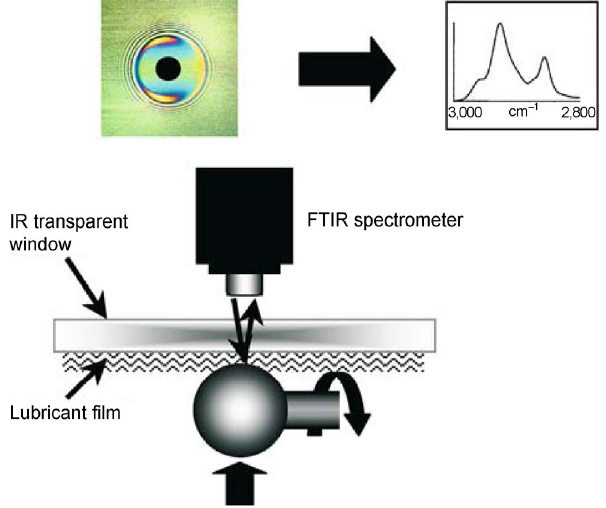
Fig. 6 Sketch for in-contact IR spectroscopy by Cann and Spikes [68]. Copyright 2005, Springer Science+Business Media, Inc.